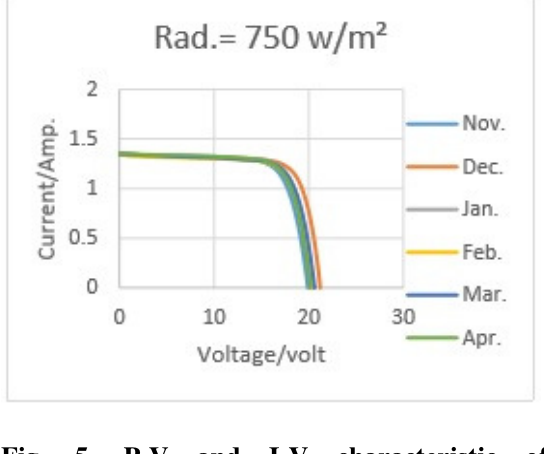
Fig. 5. P-V and I-V characteristic of monocrystalline PV solar cell at constant radiation 750W/m².